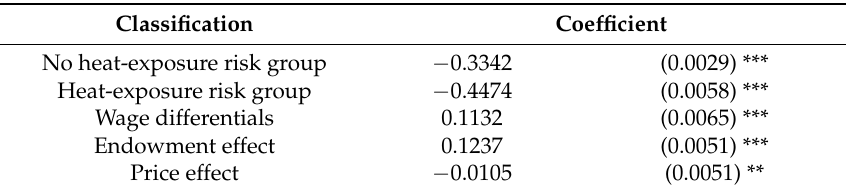
Table 4. Overall result of the Blinder-Oaxaca decomposition.